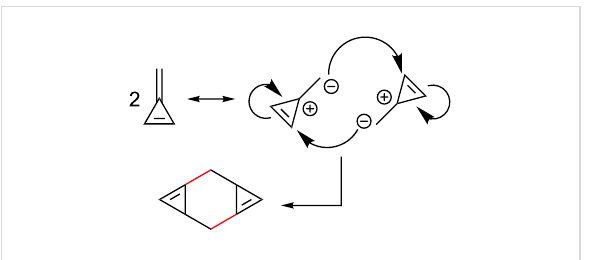
Scheme 7: Triafulvene dimerization through the proposed 'head-to-tail' mechanism. The dipolar transition state is shown as the intermediate [4].